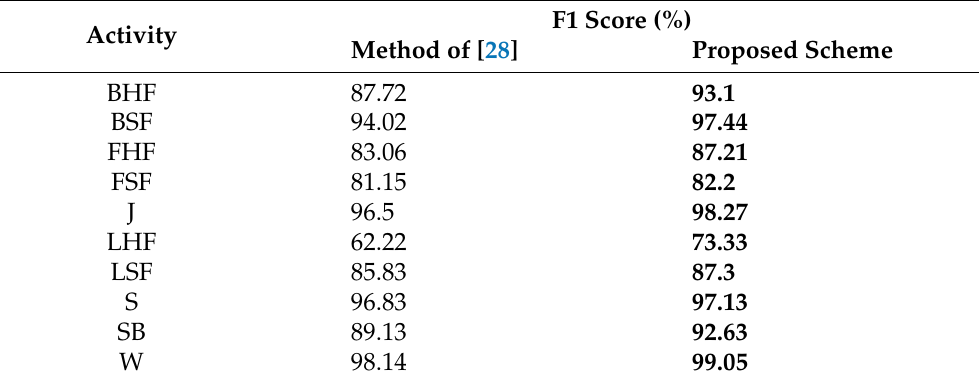
Table 6. Comparison of proposed scheme to the work in